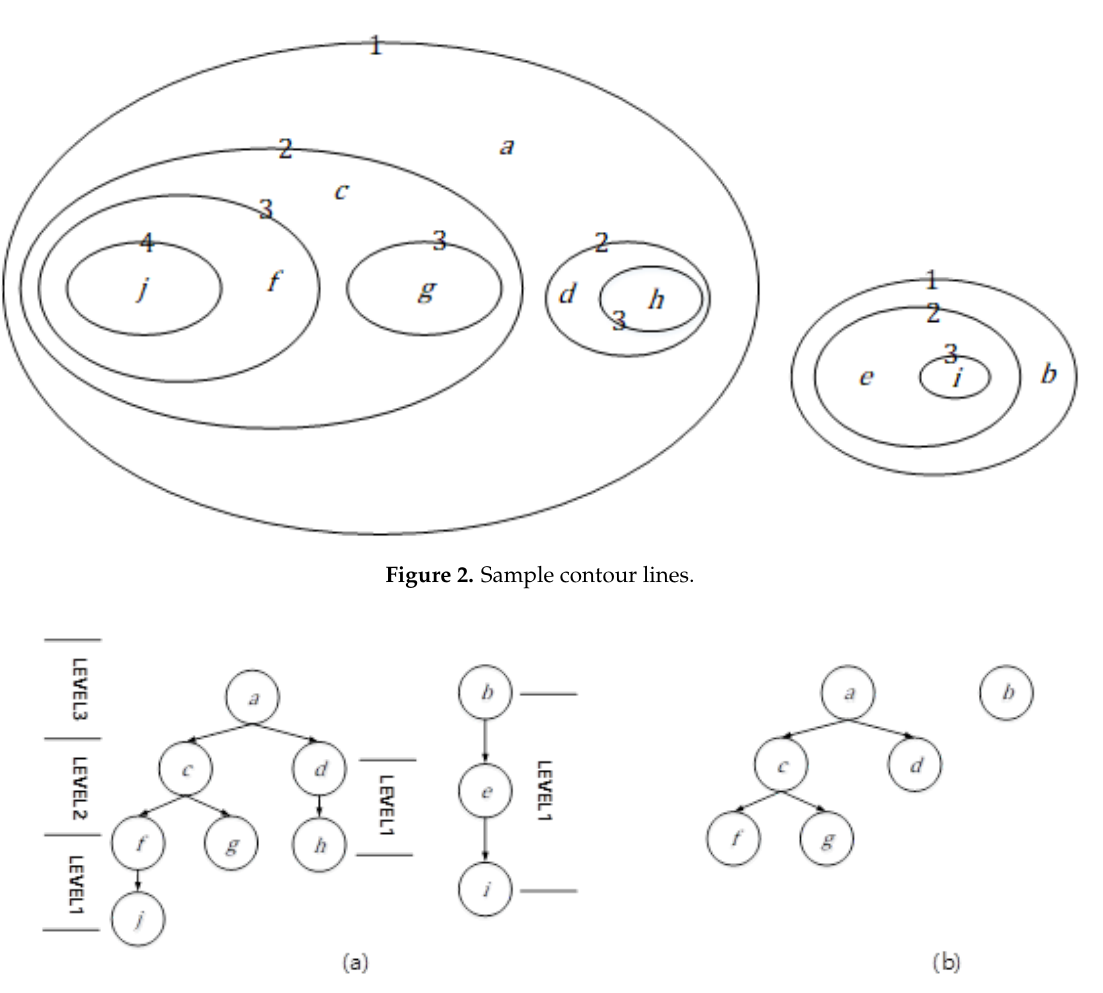
Figure 3. ( a ) Sample contour trees; ( b ) simplified sample contour trees.